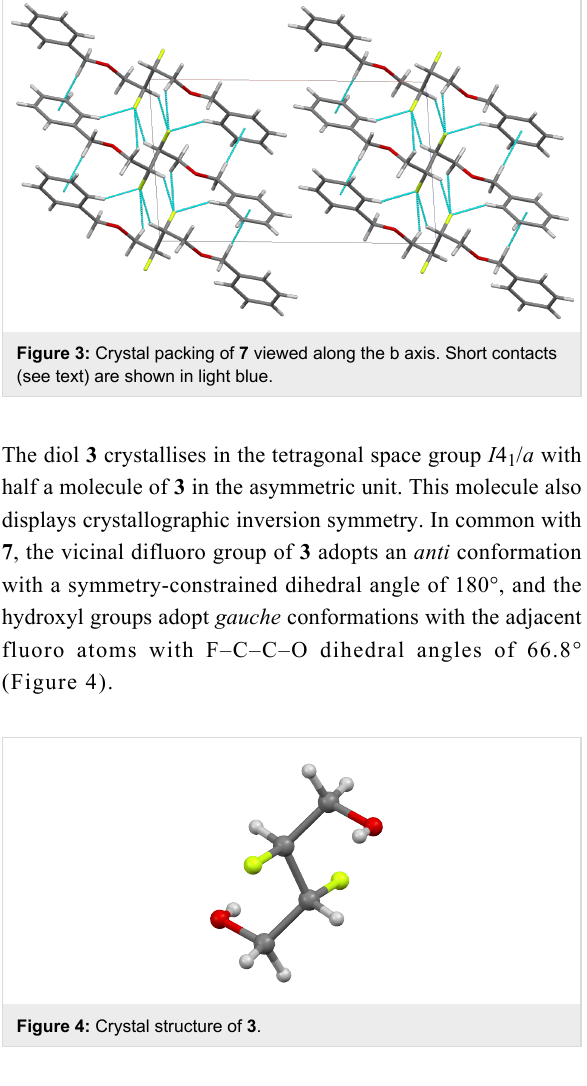
There is strong hydrogen bonding between the hydroxyl groups of the molecule with each hydroxyl group acting both as donor and acceptor (O–H···O: 2.685 Å, 170.1°). The hydrogen bonded